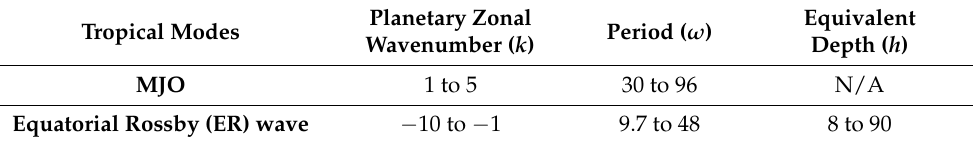
Table 2. The range of planetary zonal wavenumber, period (days), and equivalent depth (m) chosen for filtering MJO and n = 1 equatorial Rossby (ER) wave. “N/A” means the region of filtering does not follow the dispersion curve. The wavenumber-frequency ranges are based on Wheeler and Kiladis